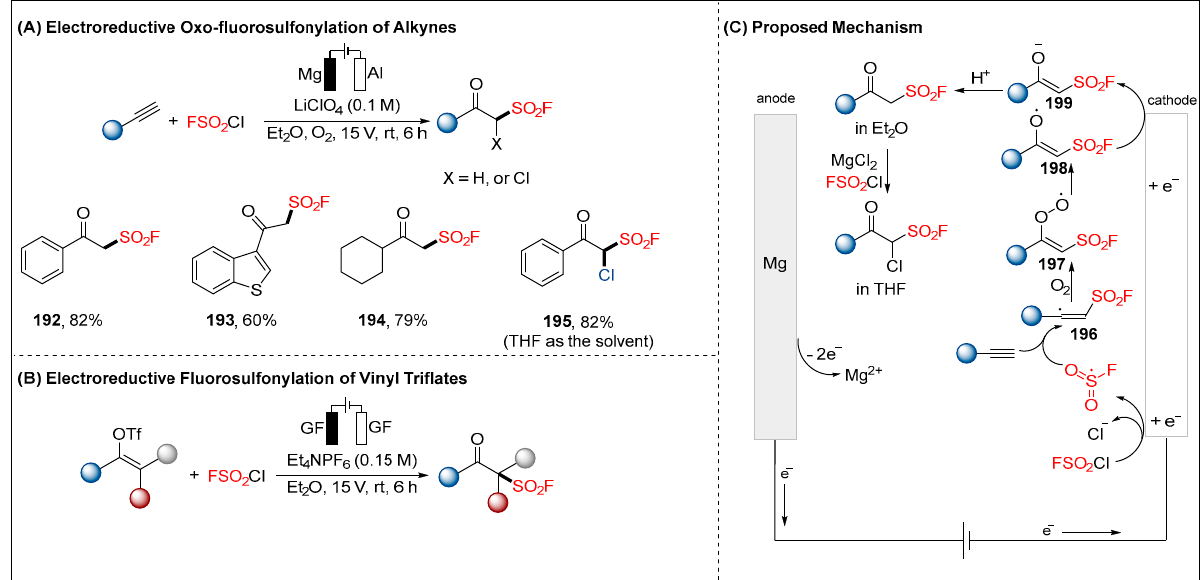
Figure 22. Electroreductive fluorosulfonylation of alkynes or vinyl triflates for the synthesis of β -keto sulfonyl fluorides by Liao